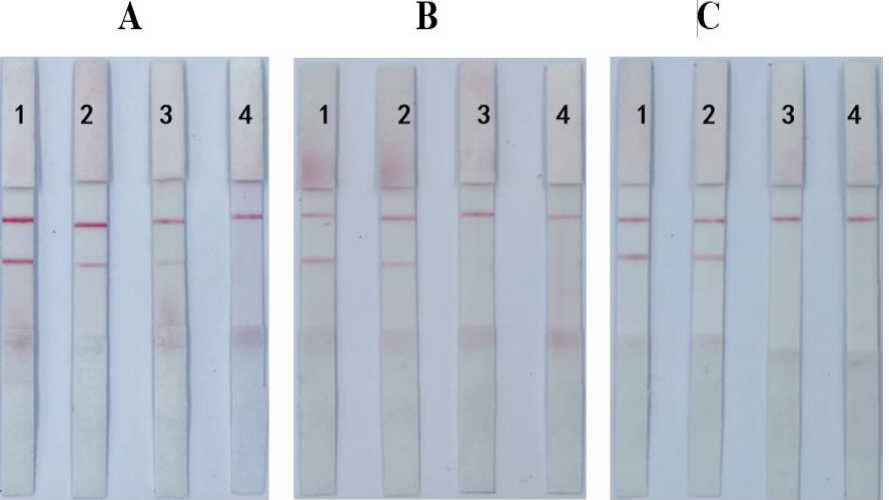
Figure 5. Optimization of loading solution of the ICS. ( A ) AFB1 test strips; ( B ) ZEN test strips; ( C ) T-2 test strips. Note: 1–4—separate loading solutions without 0.005% SDS; loading solution containing 0.005% SDS; standard solution without 0.005% SDS; standard solution containing 0.005% SDS.